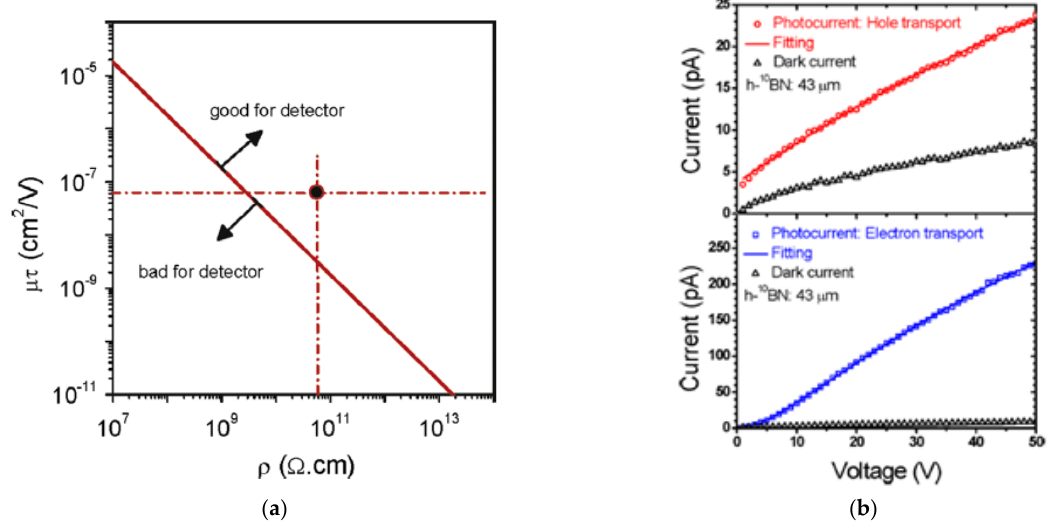
Figure 9. ( a ) Mobility lifetime product versus resistivity, ( b ) fitting of Many’s equation to obtain product (Figure ( a ) is reproduced from [18] copyright 2014, with permission from Elsevier, and Figure ( b ) is reproduced from [79] copyright 2016 with permission from AIP publishing).